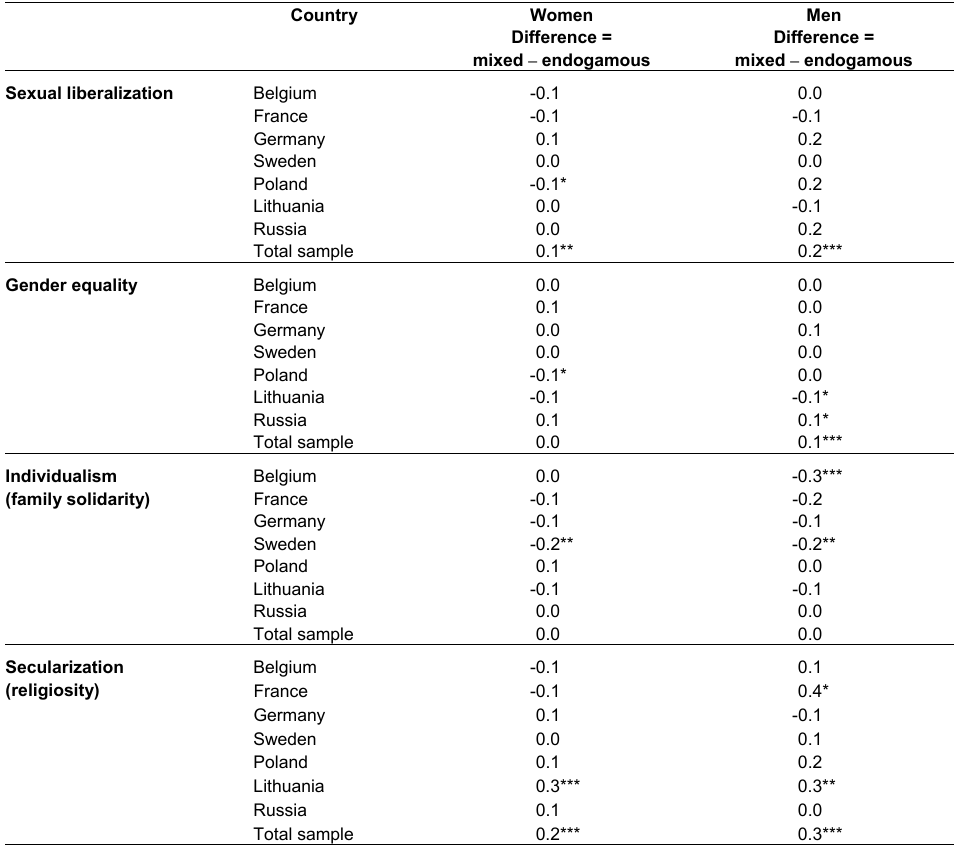
Table 1.3 : Descriptive statistics: attitudes, by sex, couple type, and country (difference between